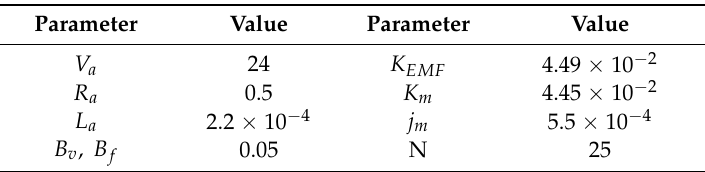
Table A1. Parameters used for the Kalman